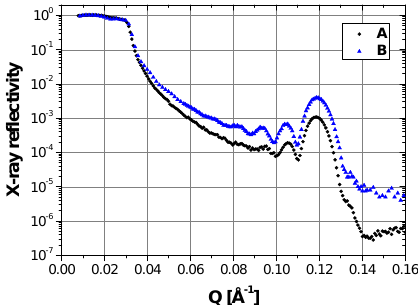
Figure 1. X-ray reflectivity of the DMPC coatings A and B at room temperature and ambient relative humidity in air, prior to incubation in PAH solutions.